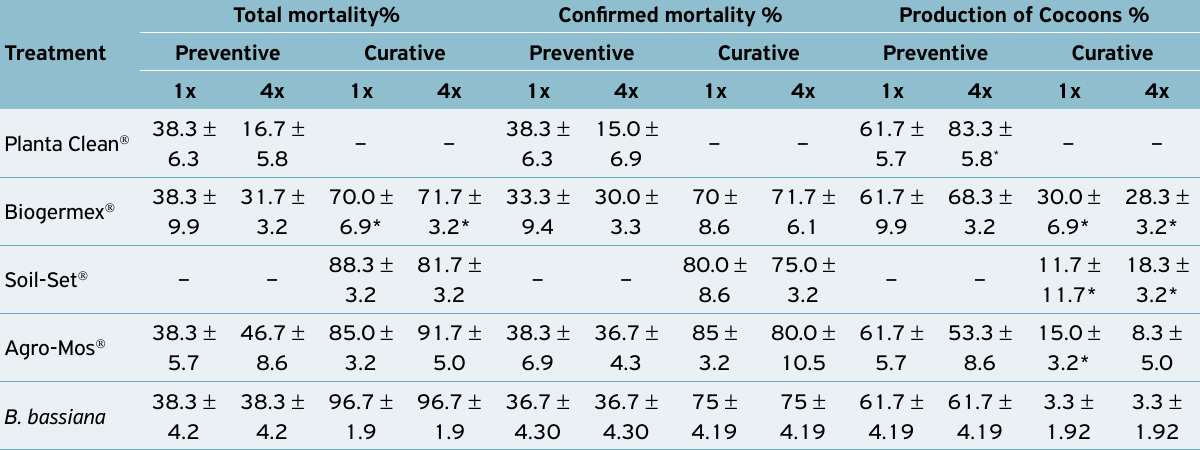
Table 3. Total and confirmed mortality, and production of cocoons of B. mori silkworms infected with the fungus B. bassiana and treated with one and four applications of alternative phytosanitary products sprayed on mulberry leaves and on silkworms (26 ± 1ºC, 12 h photophase and relative humidity of